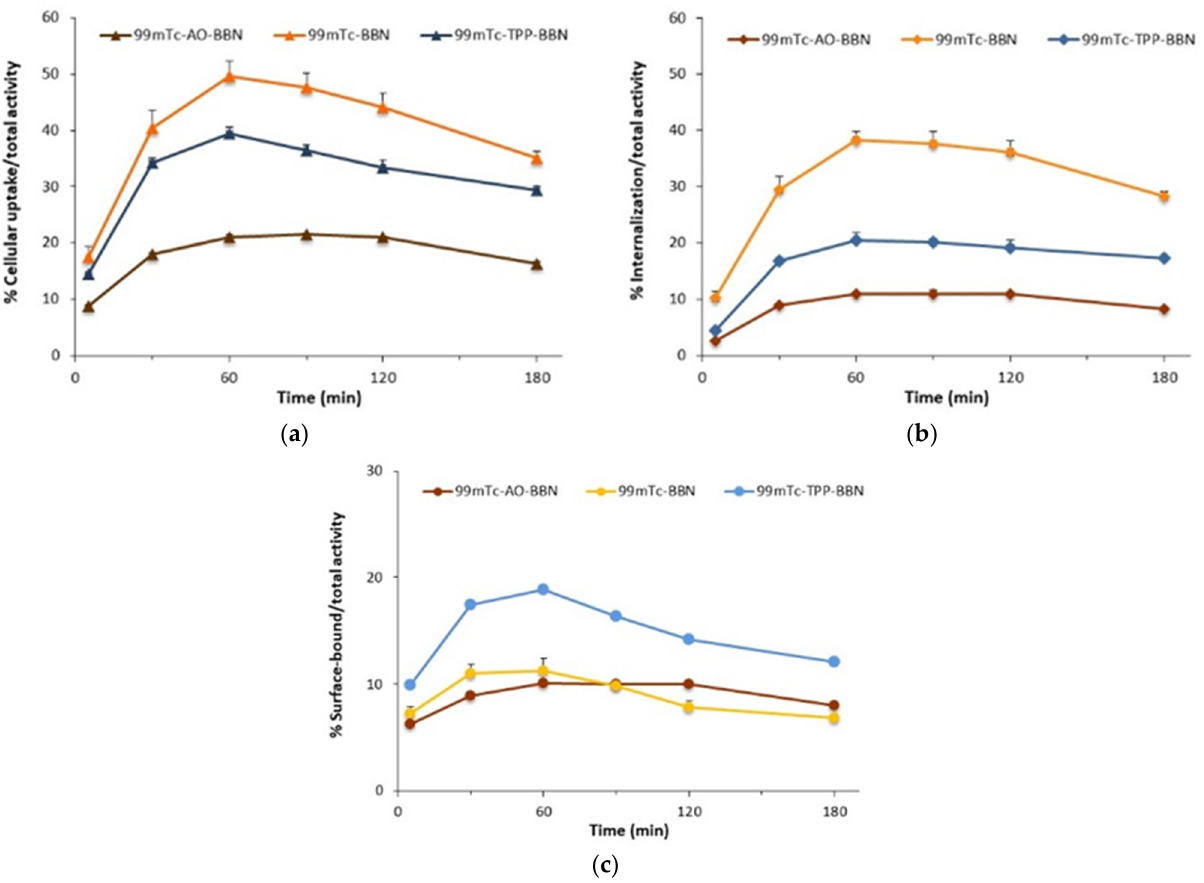
Figure 3. Time-dependent cellular uptake ( a ), internalization ( b ) and surface-bound ( c ) 99m Tc-BBN , 99m Tc-AO-BBN and 99m Tc-TPP-BBN in PC3 cells at 37 °C. The results are expressed as a percentage of the total (applied) activity and calculated from independent biological replicates (mean ± SEM, n = 4).